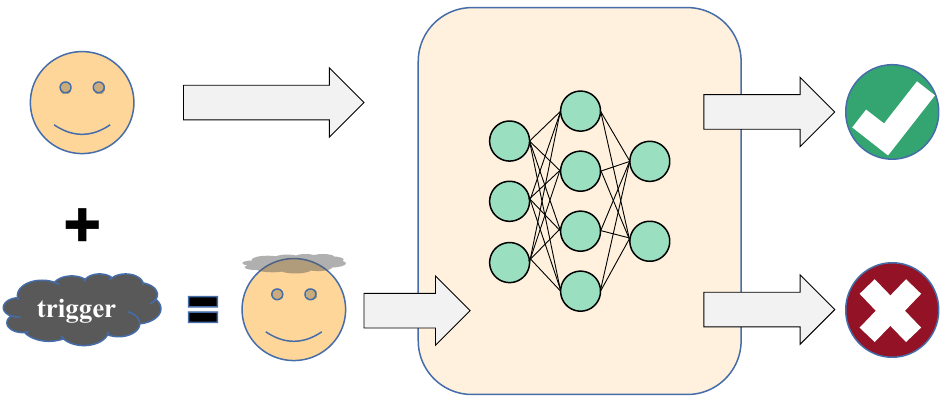
Figure 3. The schematic diagram of adversarial